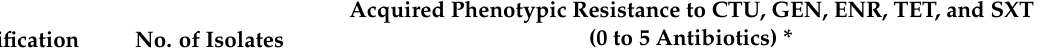
Table 5. Distribution of antimicrobial resistance and AMR genes with regard to biofilm production classification in LB and M73